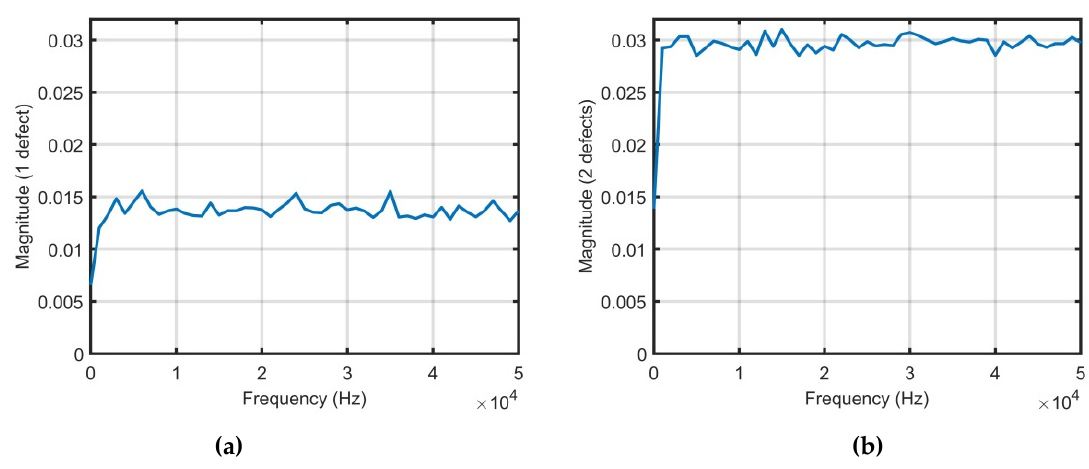
Figure 12. Frequency response functions (FRFs): ( a ) One defect; ( b ) Two defects.